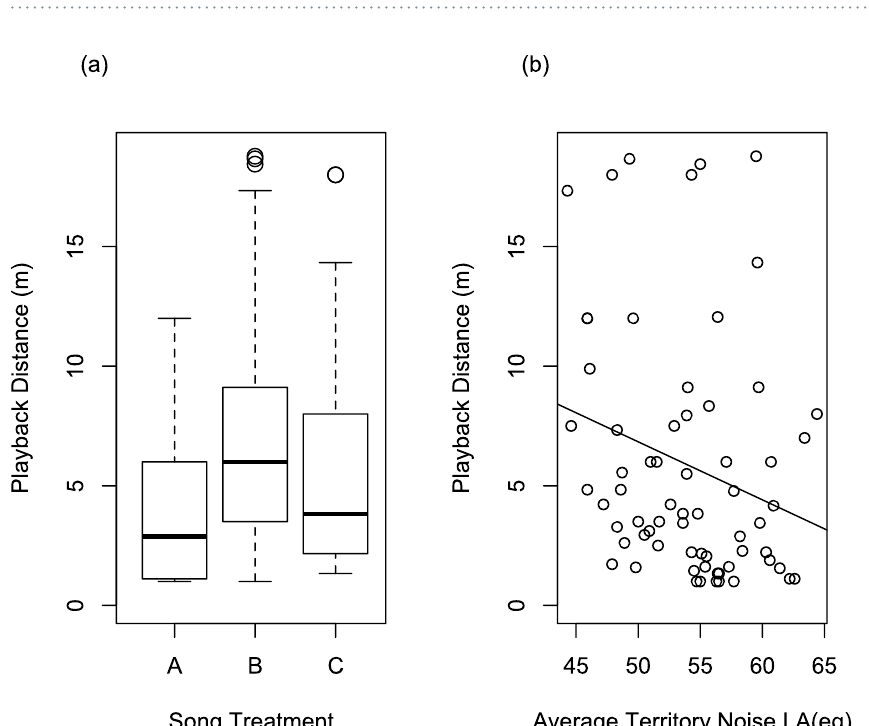
Figure 3. Playback approach distance results. ( a ) Boxplot of playback distance (m) response to three song treatments (A) fast trill, wide bandwidth (4 ± 0.74 m), (B) fast trill, narrow bandwidth (7.6 ± 1.22 m), and